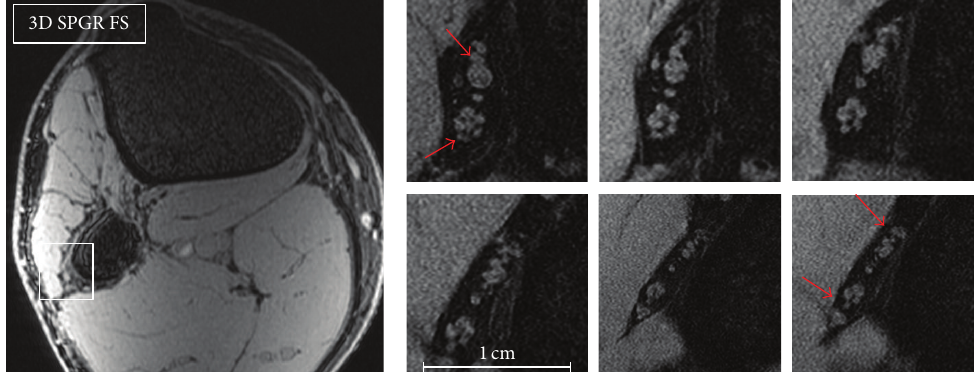
Figure 2: 3D SPGR FS, FOV 5 cm. Axial sections of the common peroneal nerve (CPN) at the level of the fibular neck. The CPN is approximately half the diameter of the tibial nerve and therefore contains fewer fascicles. It travels along the lateral aspect of the fibular neck and divides into two main branches, the deep and superficial peroneal nerves